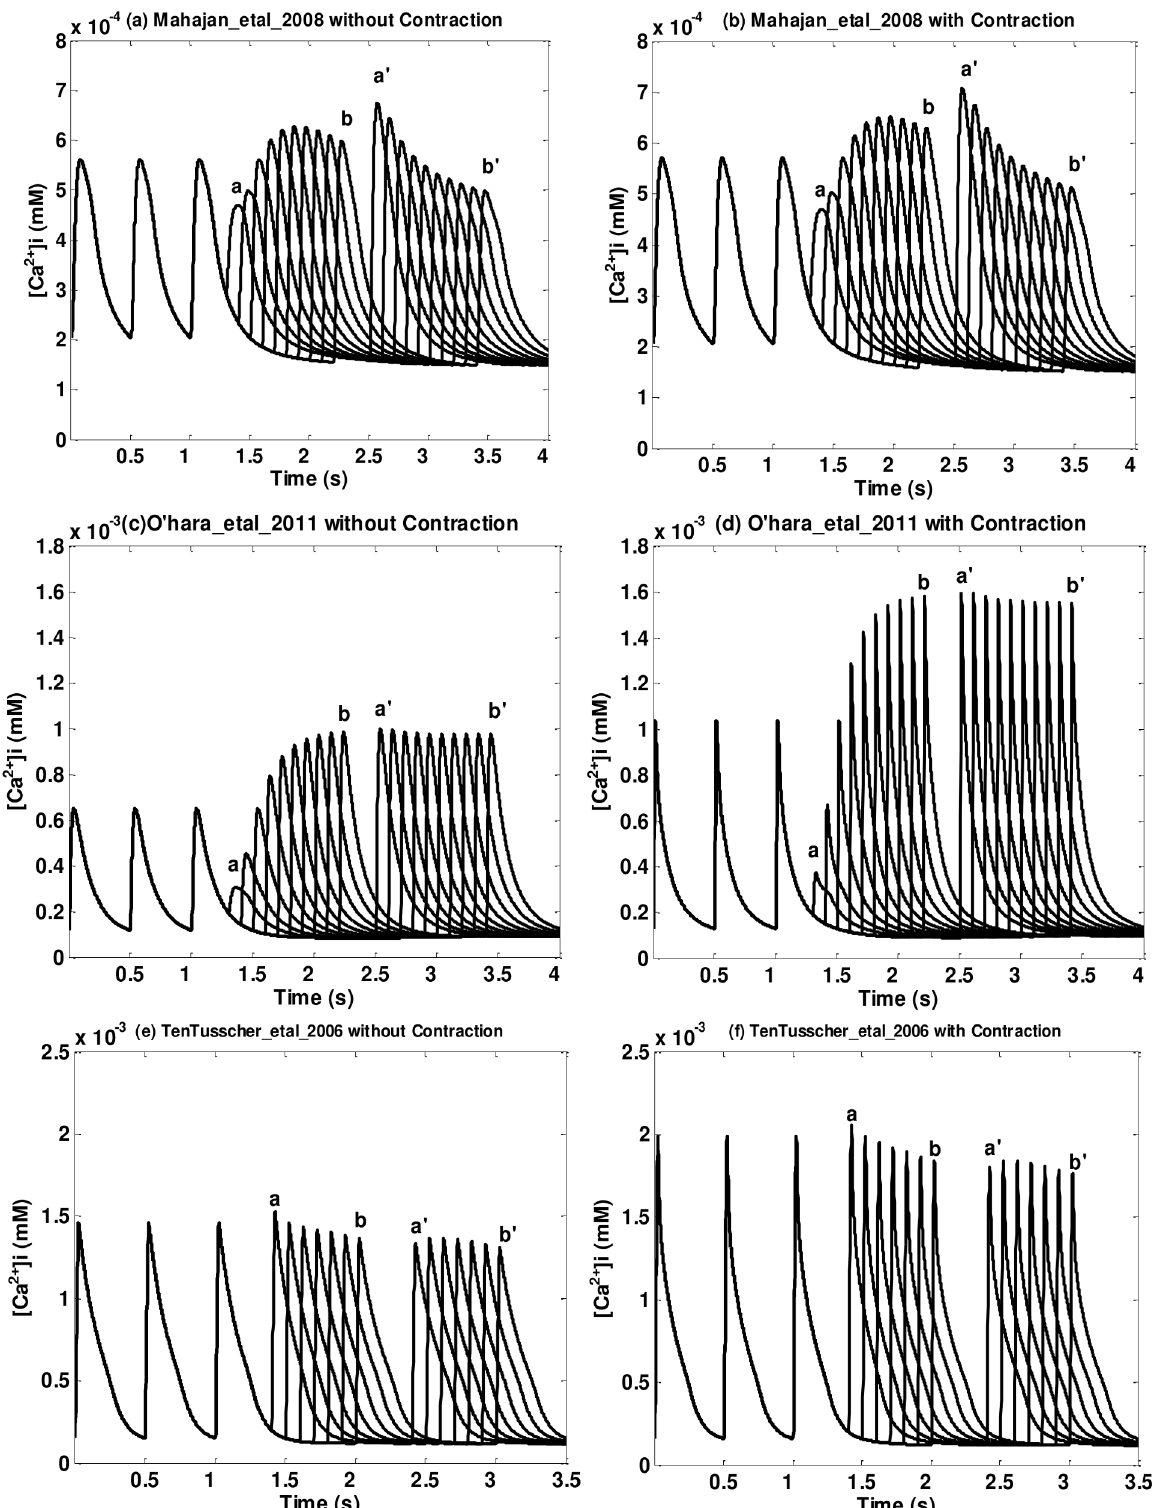
Fig 5. Postextrasystolic potentiation in [ Ca 2+ ] i transient for three models of Type Three, Four and Five. (a) (b) Mahajan_etal_2008 without/with contraction; (c) (d) O ’ hara_etal_2006 without/with contraction; (e) (f) TenTusscher_etal_2004 without/with contraction. As in the previous figure, the first